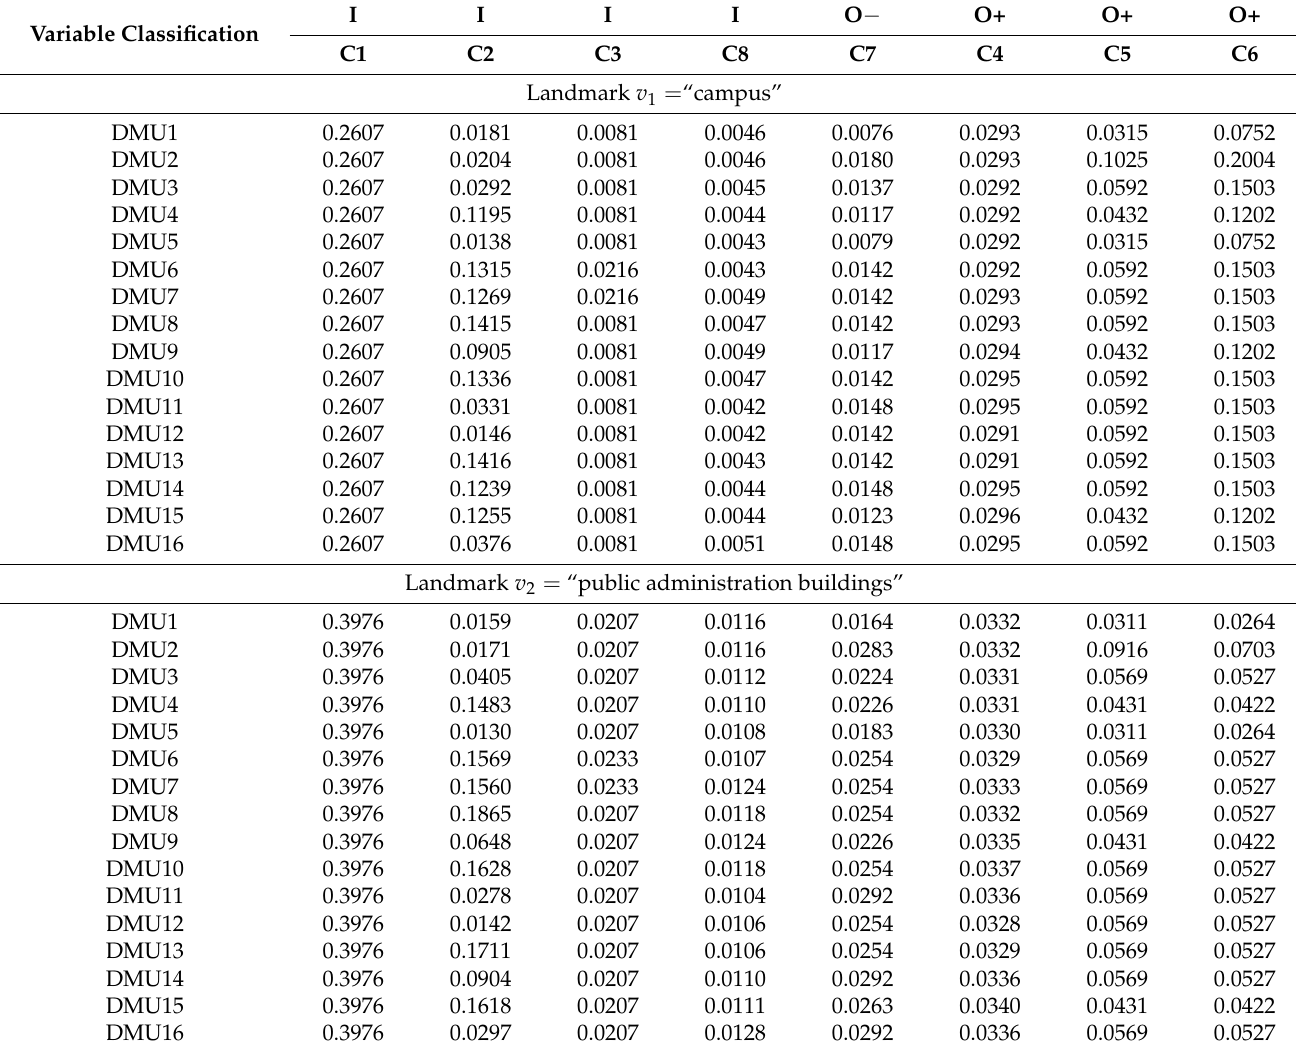
Table A3. Value of the input and output variables for the selected